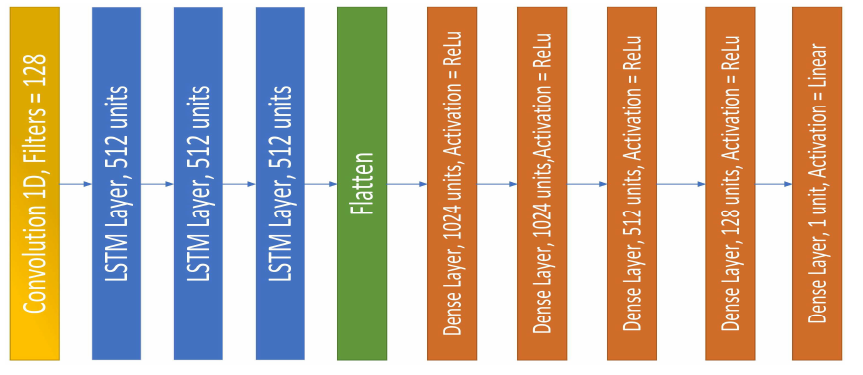
Figure 6. Architecture of the CNN-LSTM